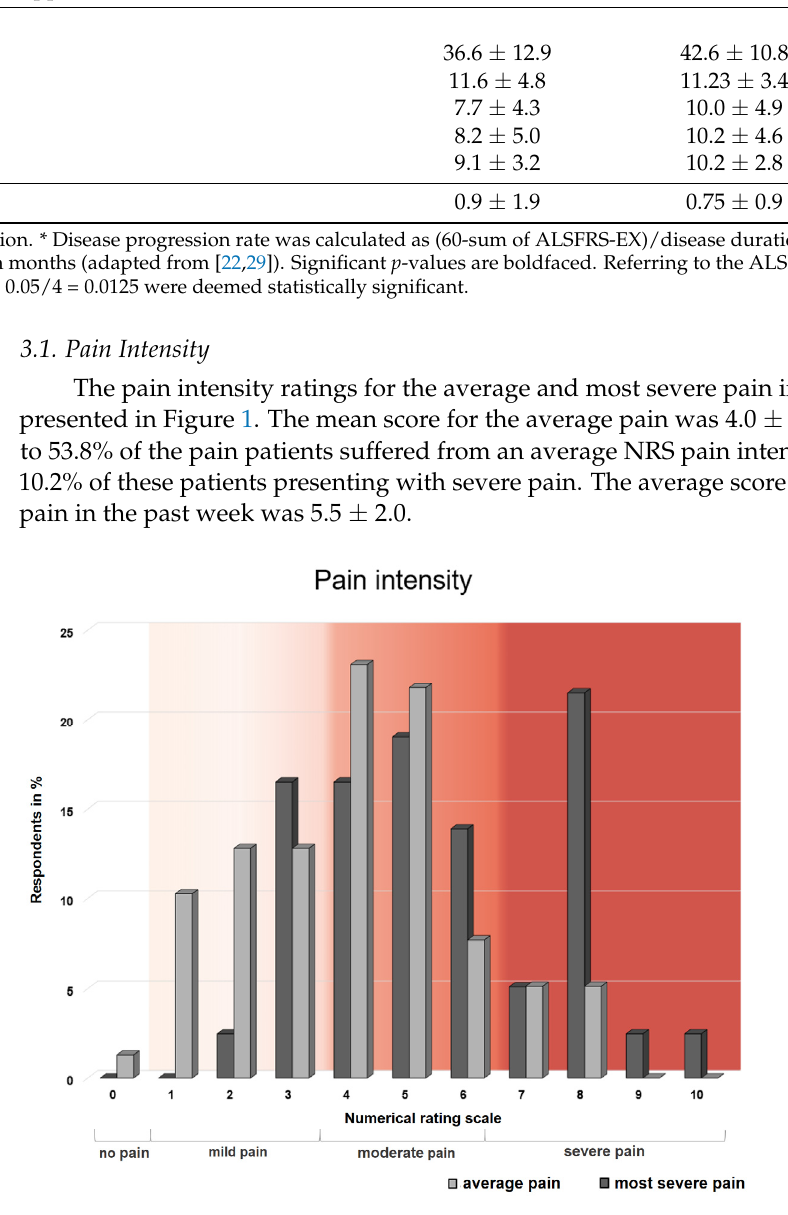
Figure 1. Pain intensity according to the Brief Pain Inventory (BPI) for the average pain in the past week (light gray bars) and for the most severe pain in the past week (dark gray bars). The number of respondents is given as percentages. The pain intensity is scaled from 0 (=no pain) to 10 (=strongest pain imaginable) points on the numerical rating scale. The increasing levels of the average pain intensity are highlighted in shades of red from lighter to darker.